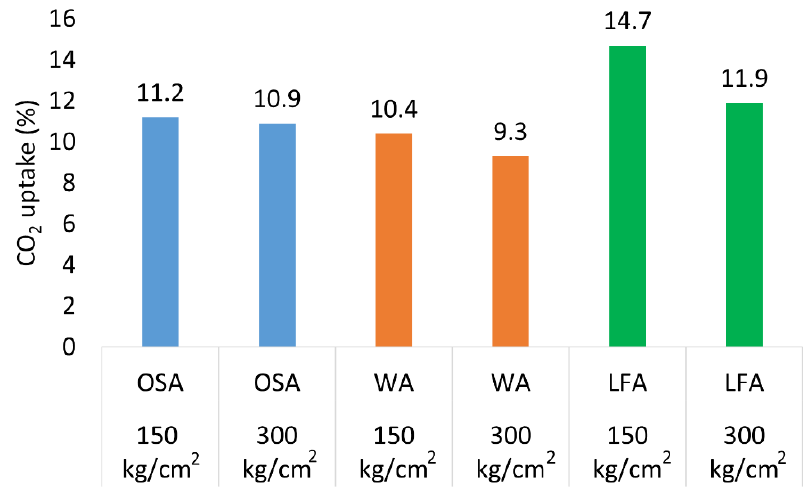
Figure 5. CO 2 uptake values at different compaction pressures for OSA, WA, and LFA (10 bar, 100% CO 2 , 25 °C) (Average values obtained from min. 4 samples (std. deviation < 3%)).